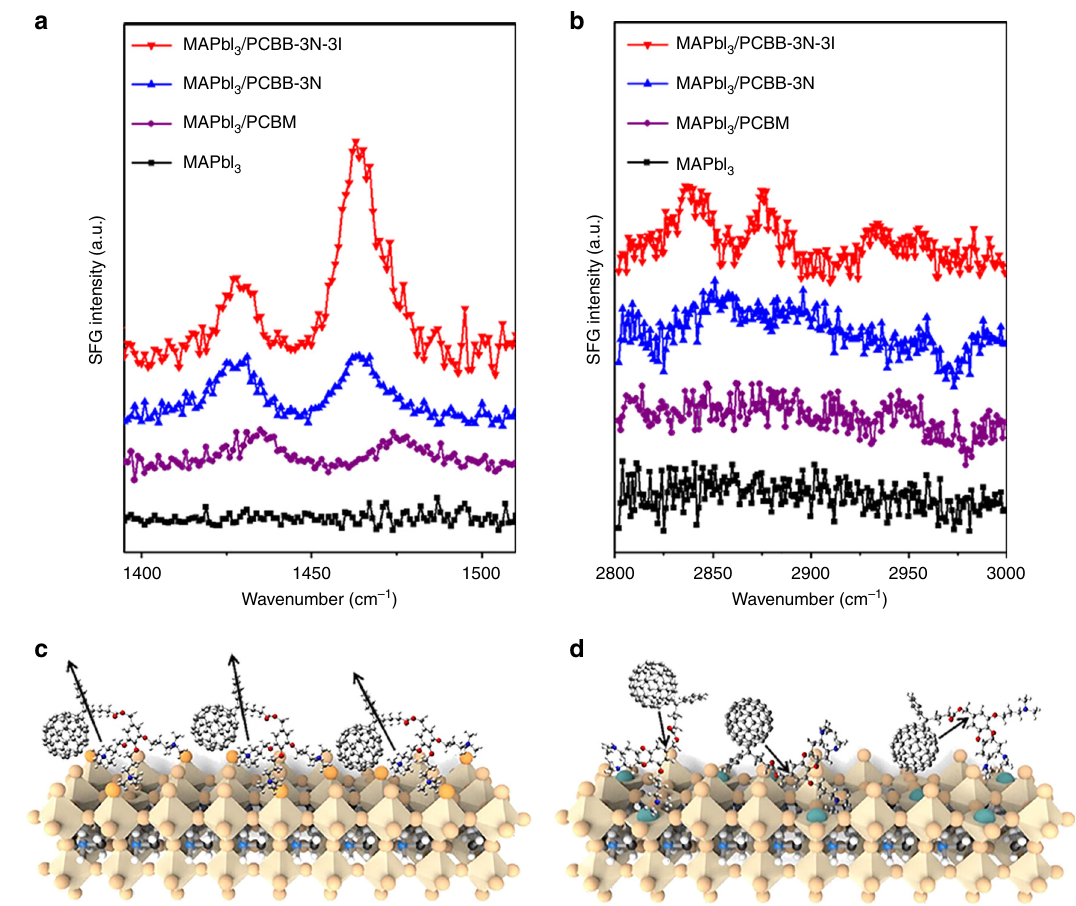
Fig. 2 The arrangement of fullerene derivatives on the perovskite fi lm. a , b SFG spectrum of perovskite before and after treatment with PCBM, PCBB-3N-3I, and PCBB-3N at a region corresponding to vibration modes for C 60 moiety and b C – H stretch region corresponding to vibration modes for pendant group. c , d Schematic illustration of molecular orientation of c PCBB-3N-3I and d PCBB-3N on MAPbI